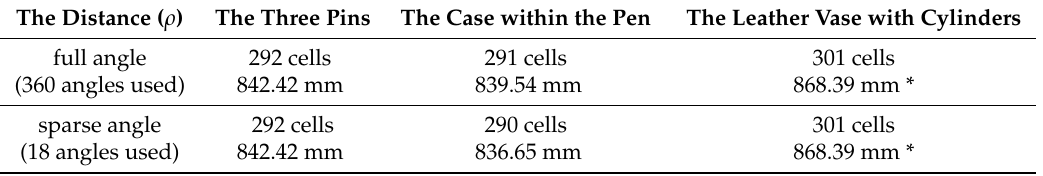
Table 2. A comparison of the results between the full angles and randomly selected angles (*: the distance was changed as the antennas were